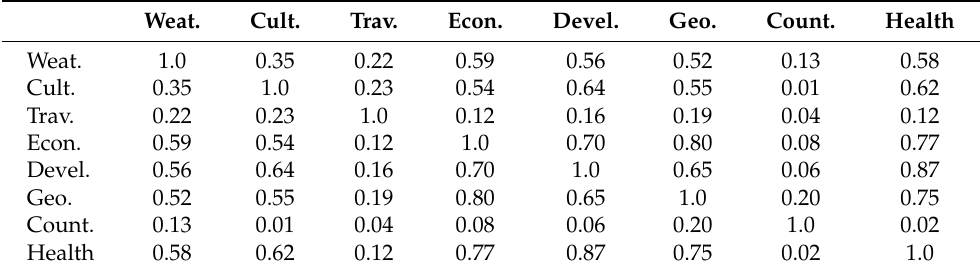
Table 9. Correlation between different feature categories. Each category was summarized by the first PCA component of all the features in the category, and correlations between these components were taken as the proxy for the correlation between the categories. Weat. Cult.